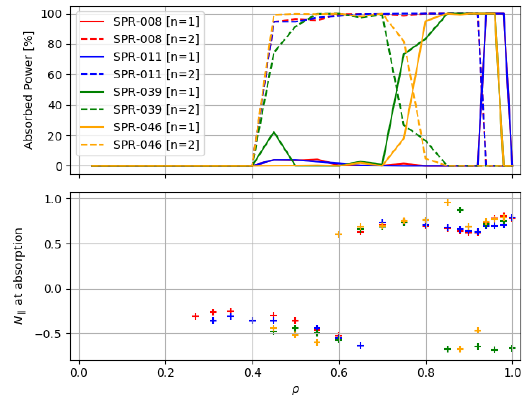
Figure 4. Percentage of total power absorbed on the 1st and 2 nd harmonic (top) and 𝑁 ∥ at absorption for each SPR. There is a transition from 1st harmonic absorption to 2 nd harmonic. This transition is further inboard SPR-039 and SPR-045. Rays with best access have negative 𝑁 ∥ . Note the SPR-008 and SPR-011 traces overlay each other (top).